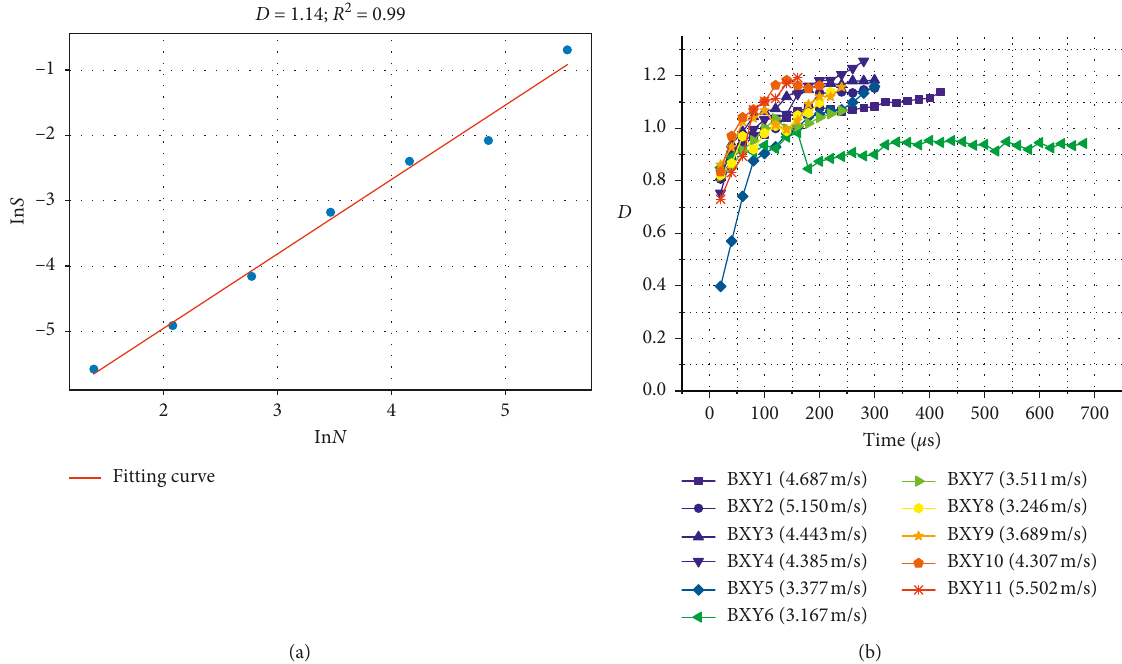
Figure 9: (a) Number of covered boxes versus box size; (b) fractal characteristics of crack for rock material under different velocities.